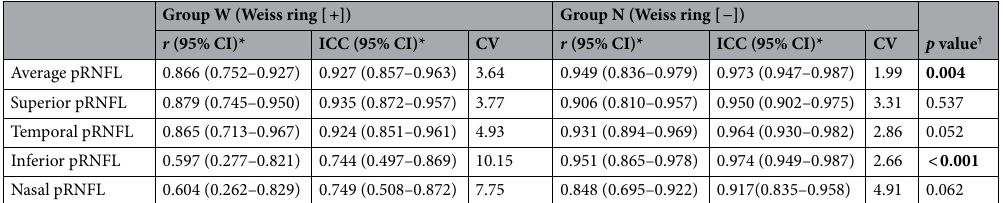
Table 4. Pearson’s correlation coefficient ( r ), intraclass correlation coefficient (ICC), and coefficient of variation (CV) for average and sectoral peripapillary retinal nerve fiber layer (pRNFL) thickness measurements at the first and second visits in groups W and N. *All p values < 0.01 for Pearson’s correlation coefficient (r) and ICC. † p value for the difference in CV between groups W and N. CI confidence interval. Significant values are in